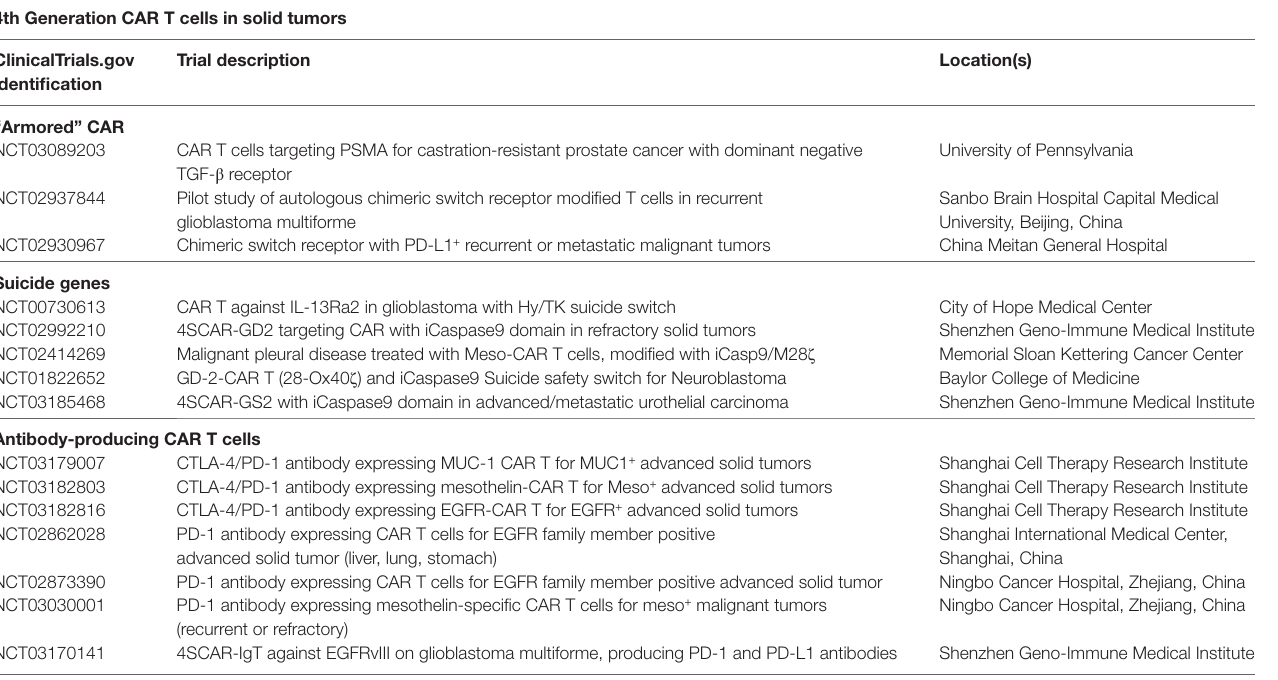
TABLe 1 | Clinical trials of fourth-generation chimeric antigen receptor (CAR) T cells in solid tumors. 4th generation CAR T cells in solid tumors ClinicalTrials.gov